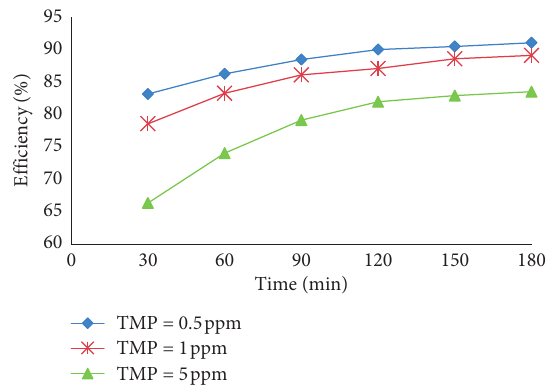
Figure 7: Effect of initial TMP concentrations on degradation during treatment processes. UV: 6W; ZnO: 500mg/L; and pH: 7.5 ±